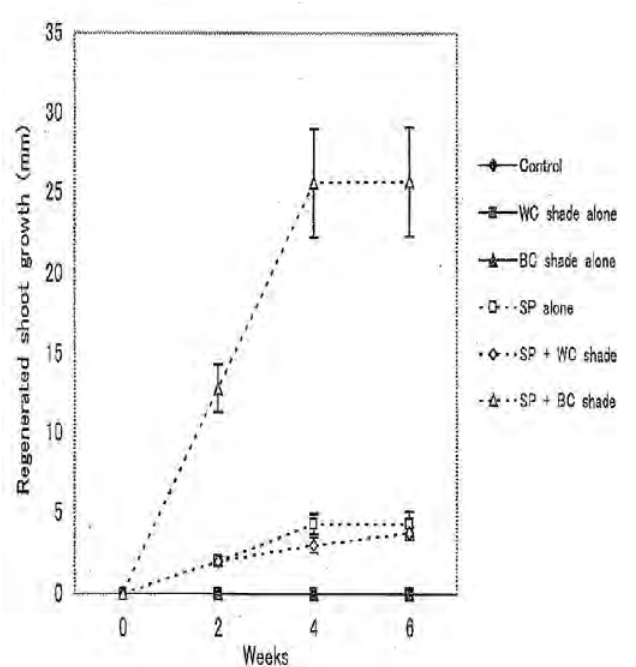
Fig. 14 - Effect of late summer pruning and shading on regenerated shoot growth of peach trees. Data are presented as mean ± standard error ( se ).